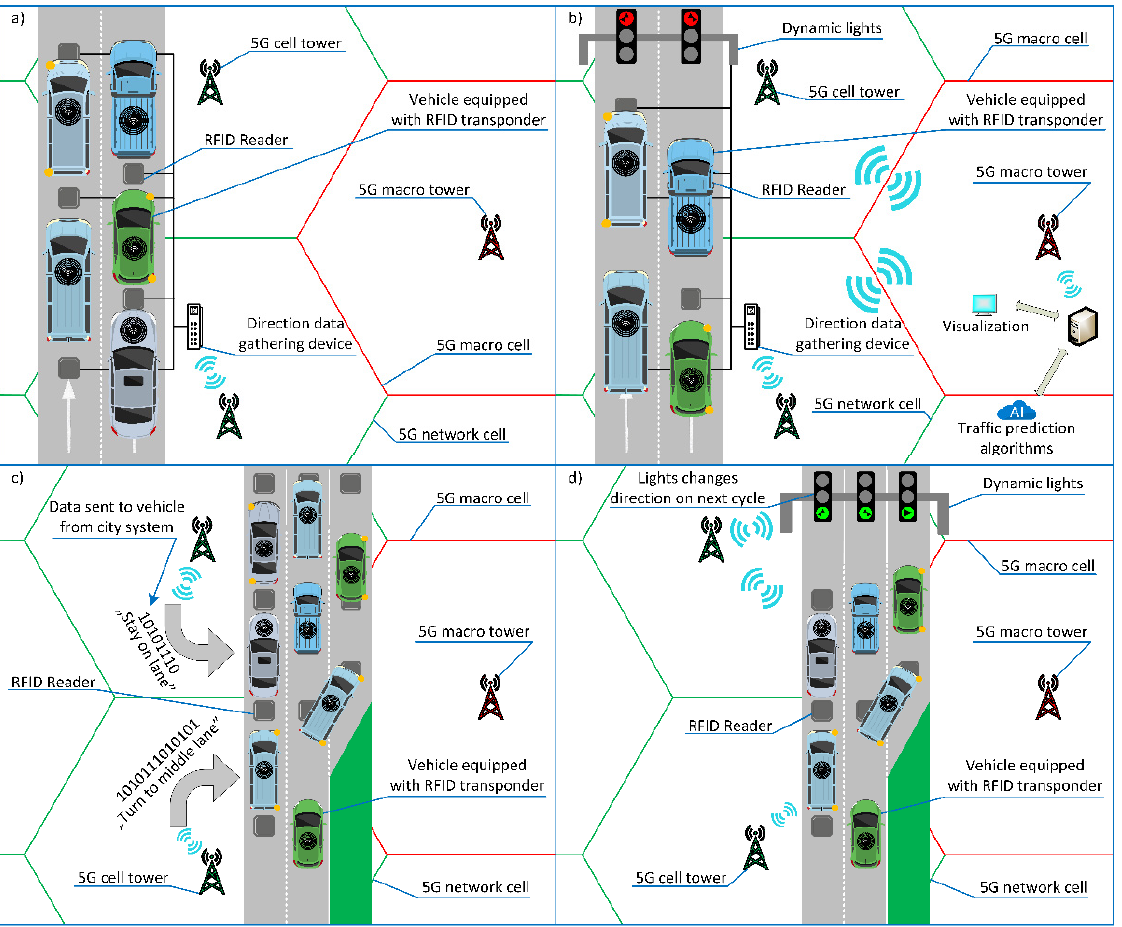
Figure 4. Management of access to lanes using RFID data ( a ) Getting vehicle data with RFID readers; ( b ) Sending to the traffic management center using 5G; ( c ) Receiving feedback from the center; ( d ) Establishing traffic lane arrangement;.